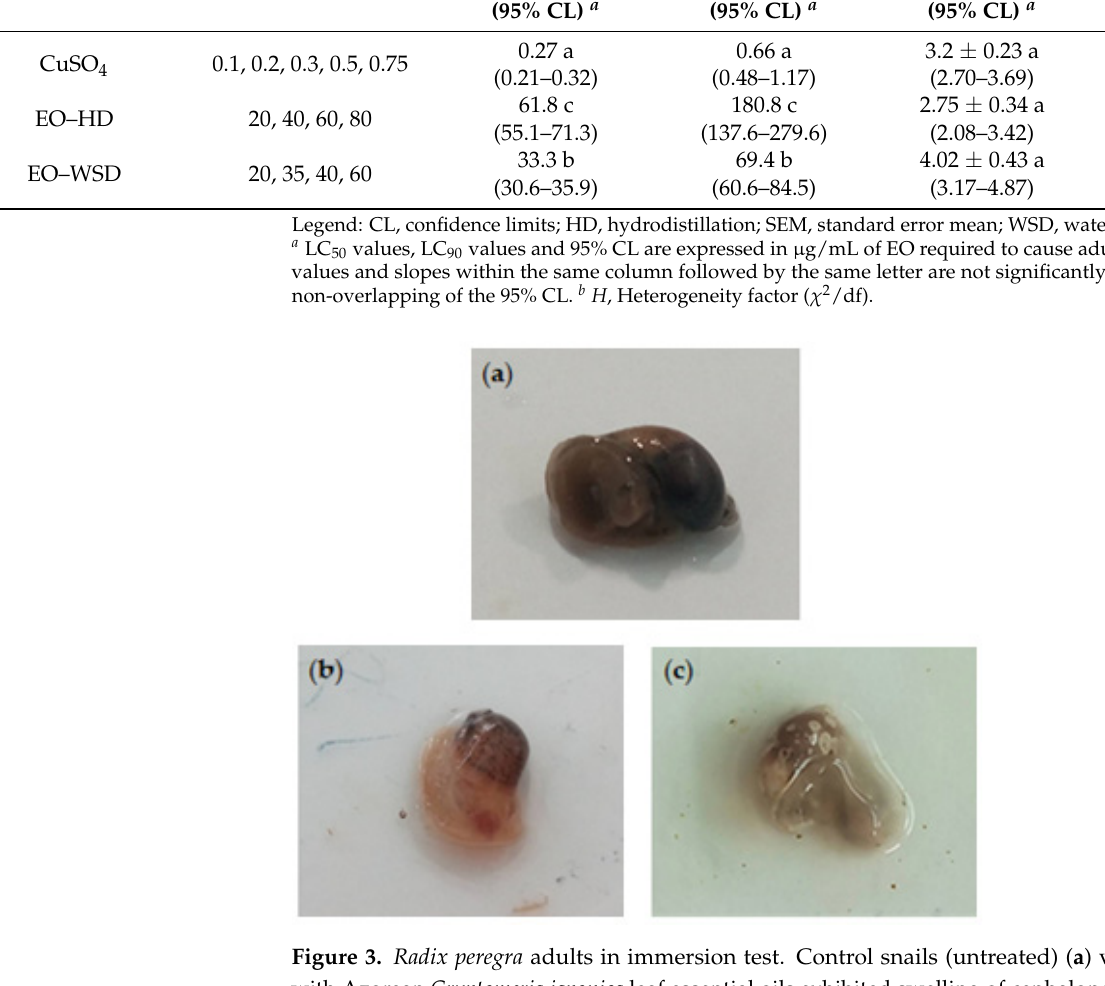
Table 3. Estimated lethal time of 50 and 90 (LT 50 and LT 90 ) of the essential oils (EOs) of Azorean Cryptomeria japonica leaf obtained by two distillation techniques against adults of Radix peregra , as- sessed for di ff erent exposure periods at 100 µg/mL.